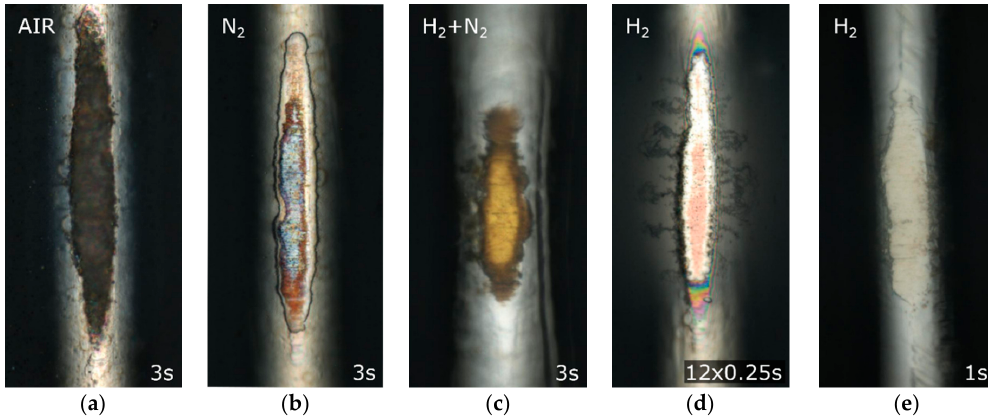
Figure 7. Exposed metal wires after etching in ( a ) ambient air plasma, ( b ) nitrogen plasma, ( c ) H 2 /N 2 plasma (50%) and ( d , e ) hydrogen plasma. Samples ( a – d ): treatment time 3 s (12 × 0.25 s for sample ( d )); sample ( e ): treatment time 1 s in 100% hydrogen plasma.